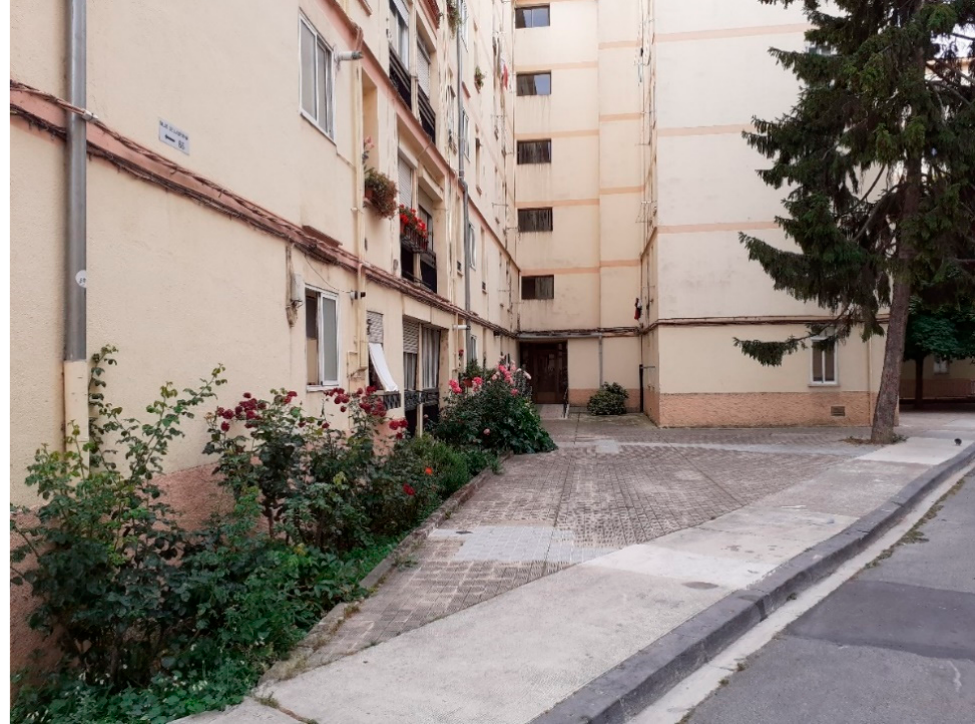
Figure 5. The existing green space with the smallest surface area: 10.59 m 2 . Square partially covered with green elements (V14 in Figure 4).